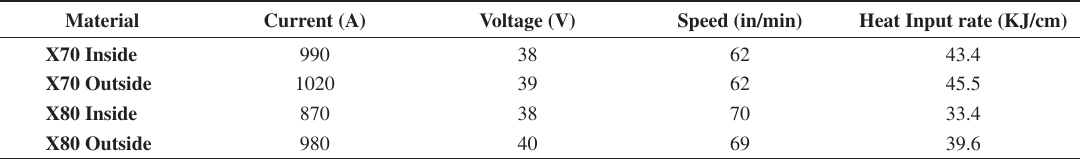
Table 2. Welding Parameters of API X70 and X80